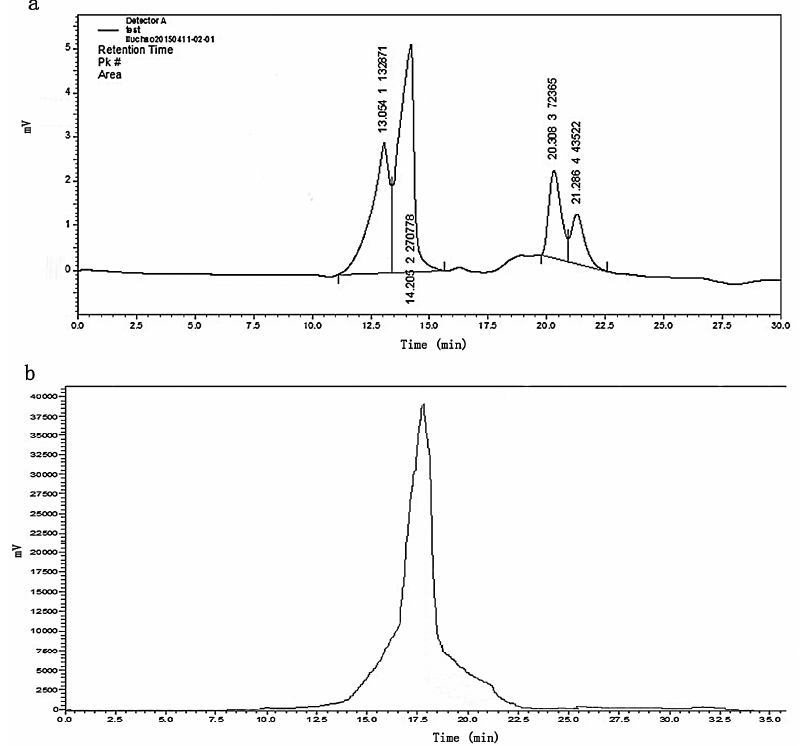
Figure 3. High-performance liquid chromatography ( HPLC) spectra of: F2 ( a ); and purified M2 ( b ).